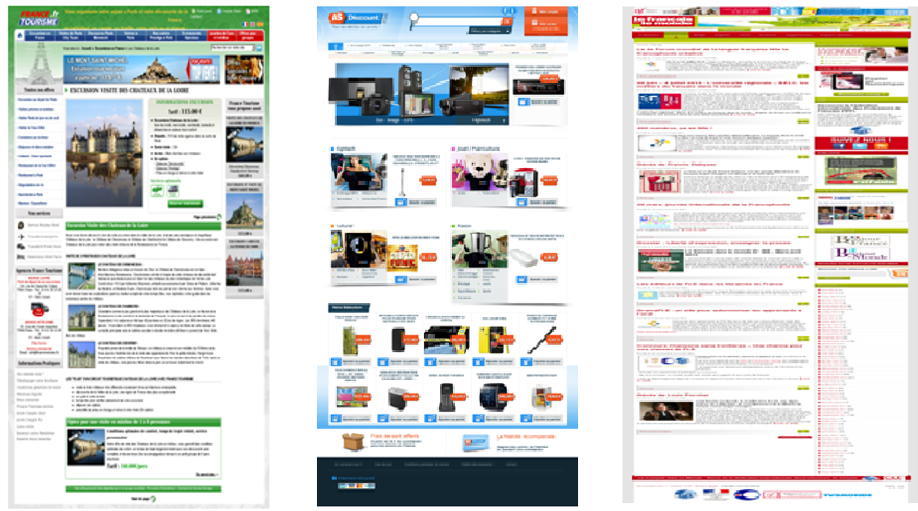
Figure 5. Three representative web pages: tourism ( left ), e-commerce ( middle ), and news ( right